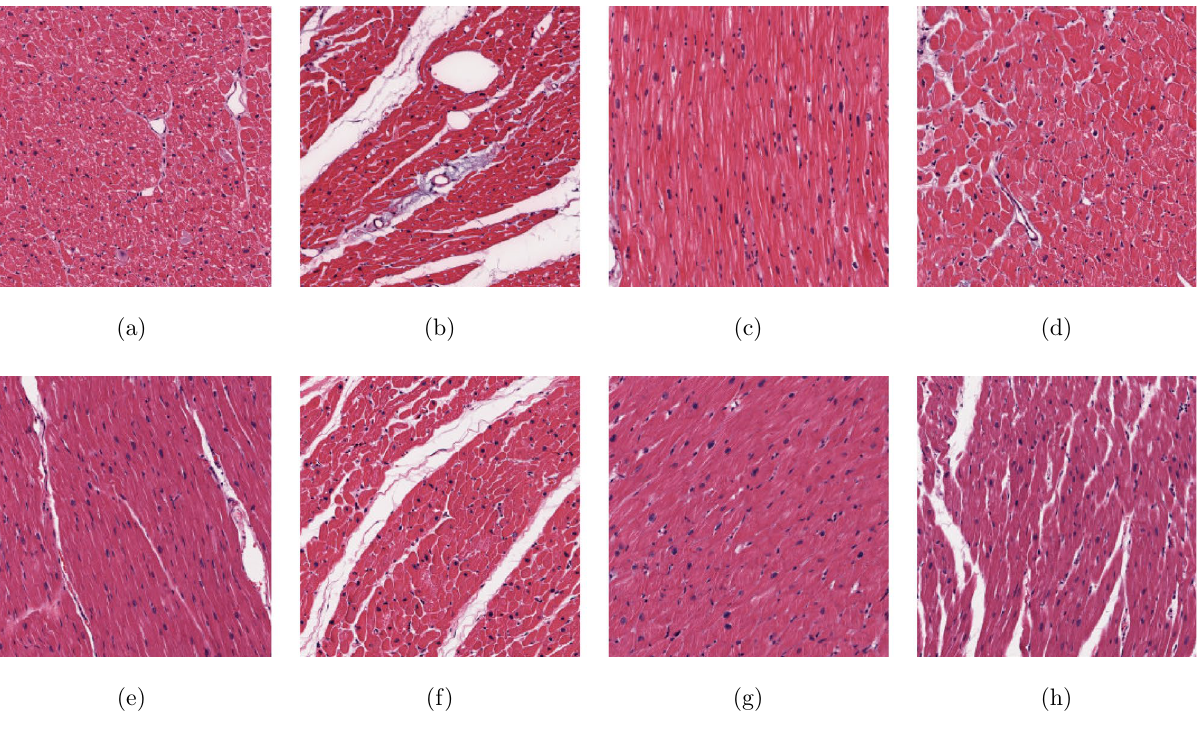
Figure 2. H&E stained heart tissue sections: ( a )–( d ) normal condition, and ( e )–( h )